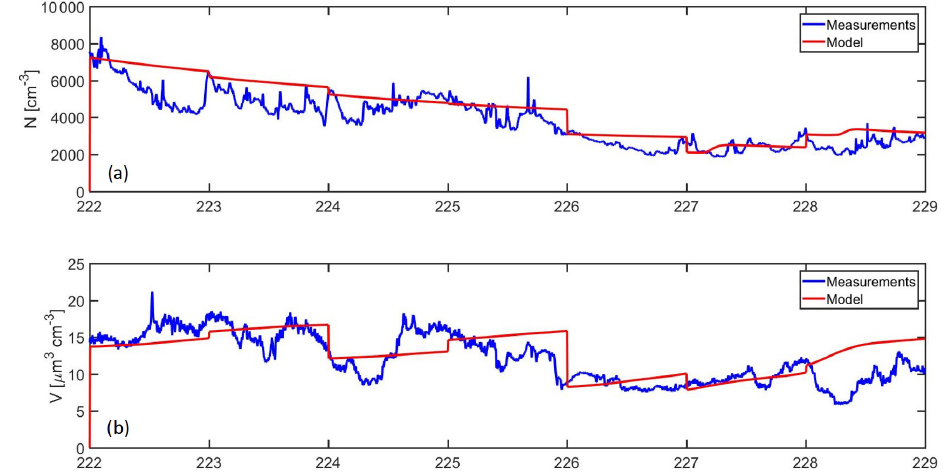
Figure 12. Simulations with the MALTE box with the adjusted parameters for the subtropical environment for the “non-event” week that no NPF was observed at Finokalia. Measured and modeled (a) total number concentration and (b) total volume concentration for the same period. The x axis in both figures gives the Julian day of